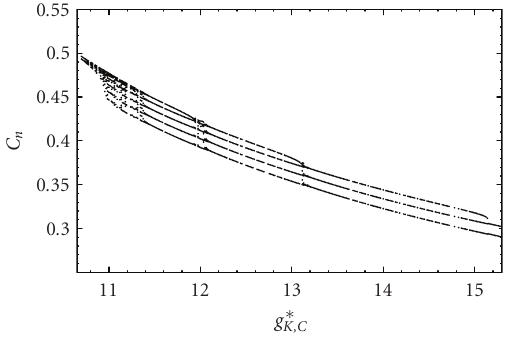
Figure 2.13. Bifurcation diagram for C with variation of g ∗